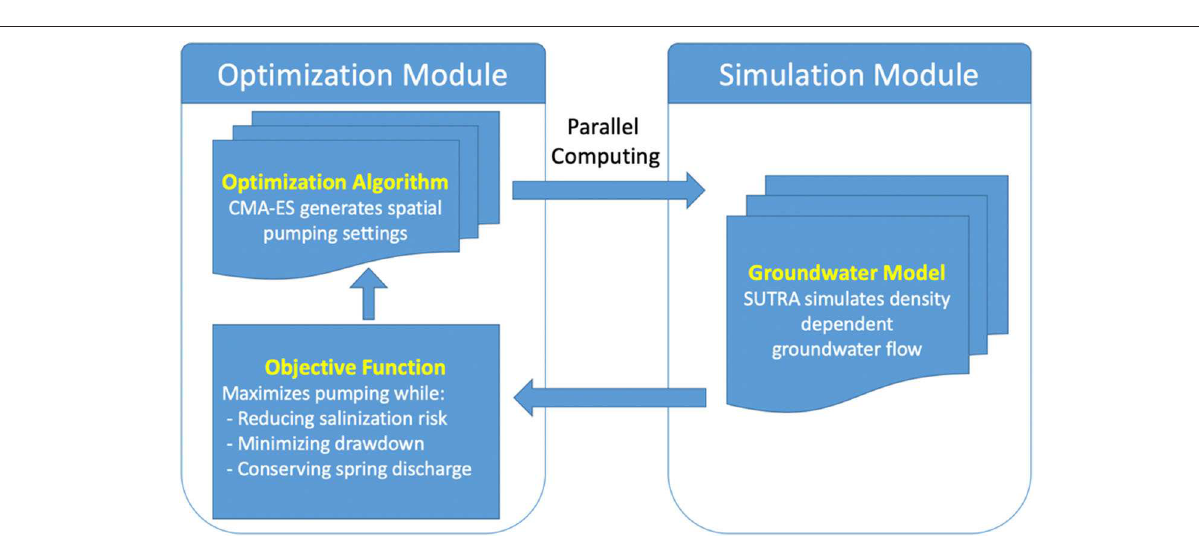
FIGURE 6 | Simulation optimization